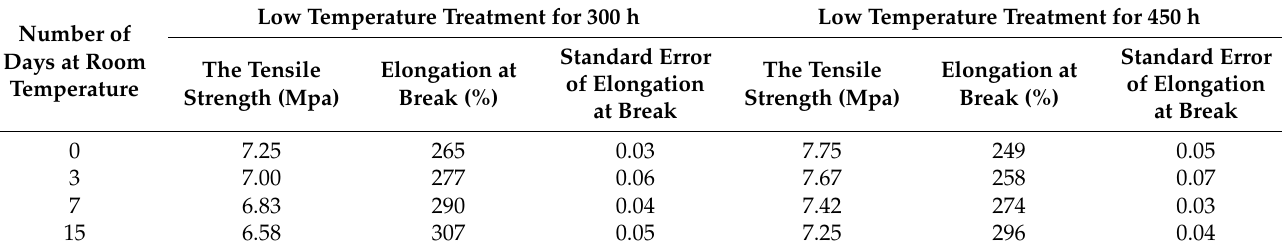
According to the experimental data, the relationship between the tensile strength and the days of storage at room temperature for samples with 300 and 450 h of low-temperature treatment was determined, as shown in Figure 8.